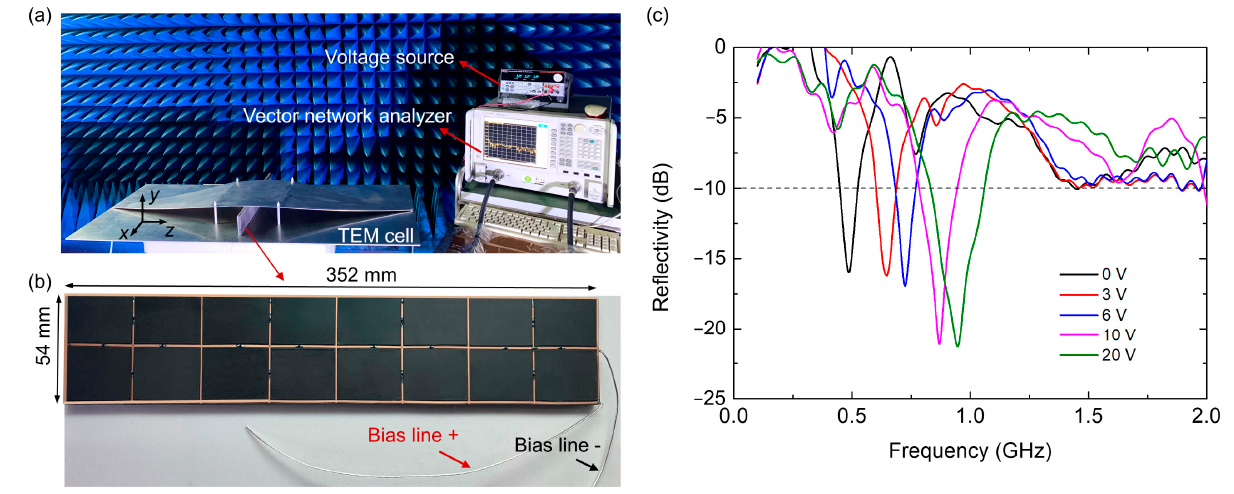
Figure 9. ( a ) Photograph of the measurement setup. ( b ) The photograph of the fabricated prototype. ( c ) Measured reflectivity of the fabricated prototype under y -polarization normal incidence.